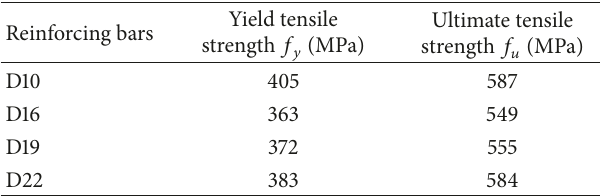
Table 1: Test results of concrete compressive strength. Table 2: Test results of reinforcing